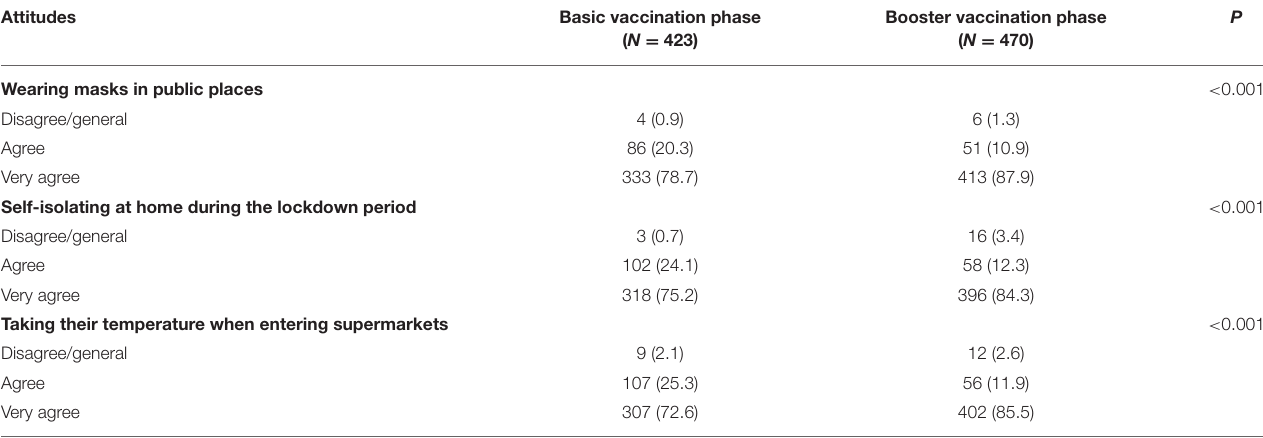
TABLE 3 | Comparison of attitudes toward government measures between two surveys. Attitudes Basic vaccination phase